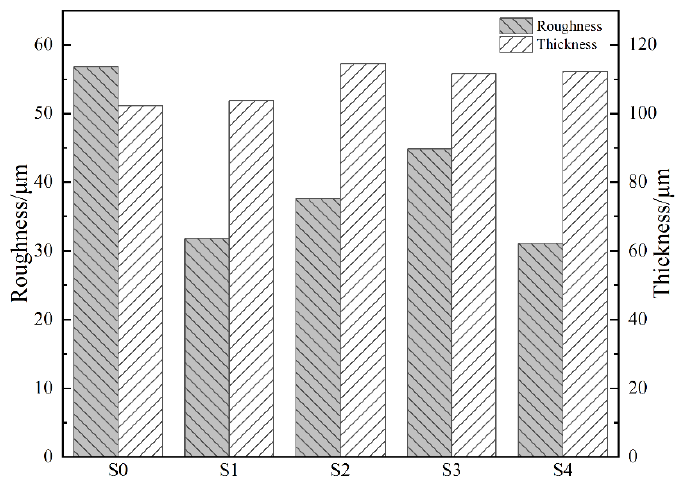
Figure 1. Thickness and roughness of MAO coatings.